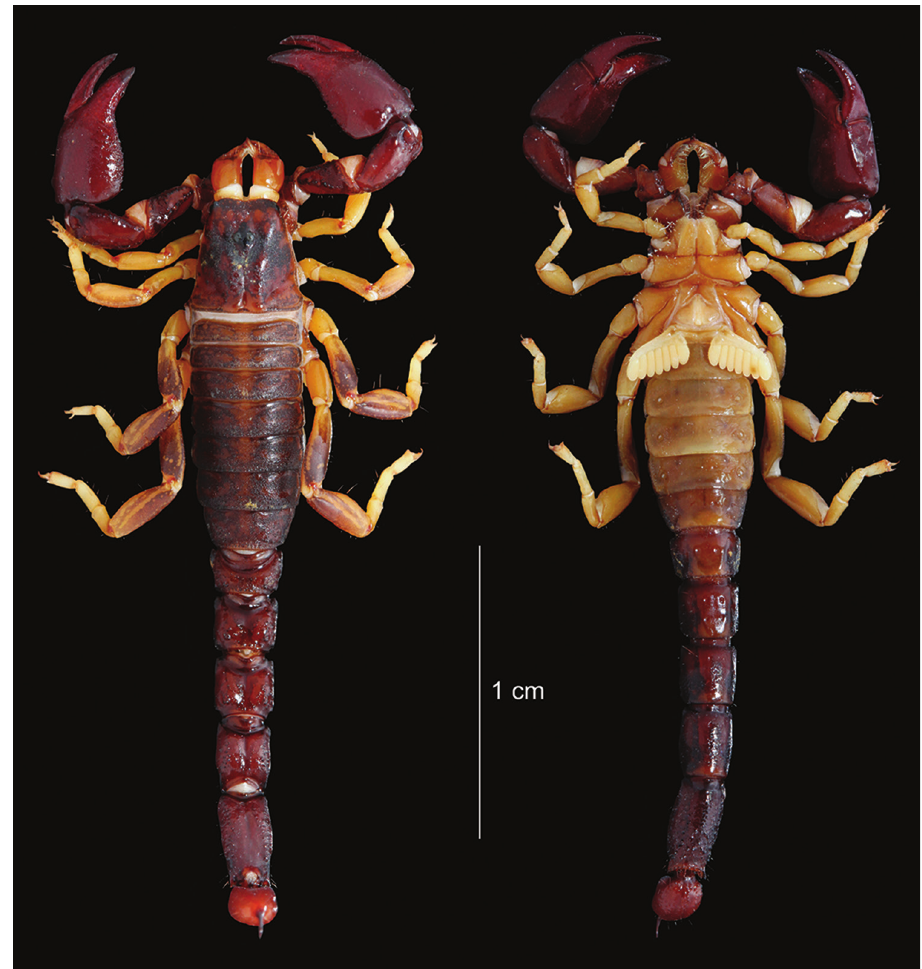
Figure 17. Auyantepuia aurum sp. n., male holotype from Saül. Habitus, dorsal and ventral aspect. weakly marked on all segments. Pedipalp femur with dorsal internal, dorsal external and ventral in ternal carinae moderately marked, internal face weakly granular, other faces smooth; patella smooth, with vestigial carinae; chela moderately granulated, with dorso-internal carina weakly marked; dentate margins on fixed and movable fingers with six rows of granules. Chelicerae with dentition typical of the family Chactidae (Vachon, 1963), and with dense setation ventrally and internally. Trichobothriotaxy of type C; neobothriotaxic ‘majorante’ (Vachon, 1974). Morphometric values (in mm) of the male holotype. Total length including telson, 25.2. Carapace: length, 3.9; an- terior width, 2.2; posterior width, 3.6. Mesosoma length, 7.7. Metasomal segments. I: length, 1.4; width, 2.0; II: length, 1.9; width, 2.0; III: length, 2.0; width, 1.7; IV: length, 2.3; width, 1.7; V: length, 3.3; width, 1.6; depth, 1.4. Telson: length,